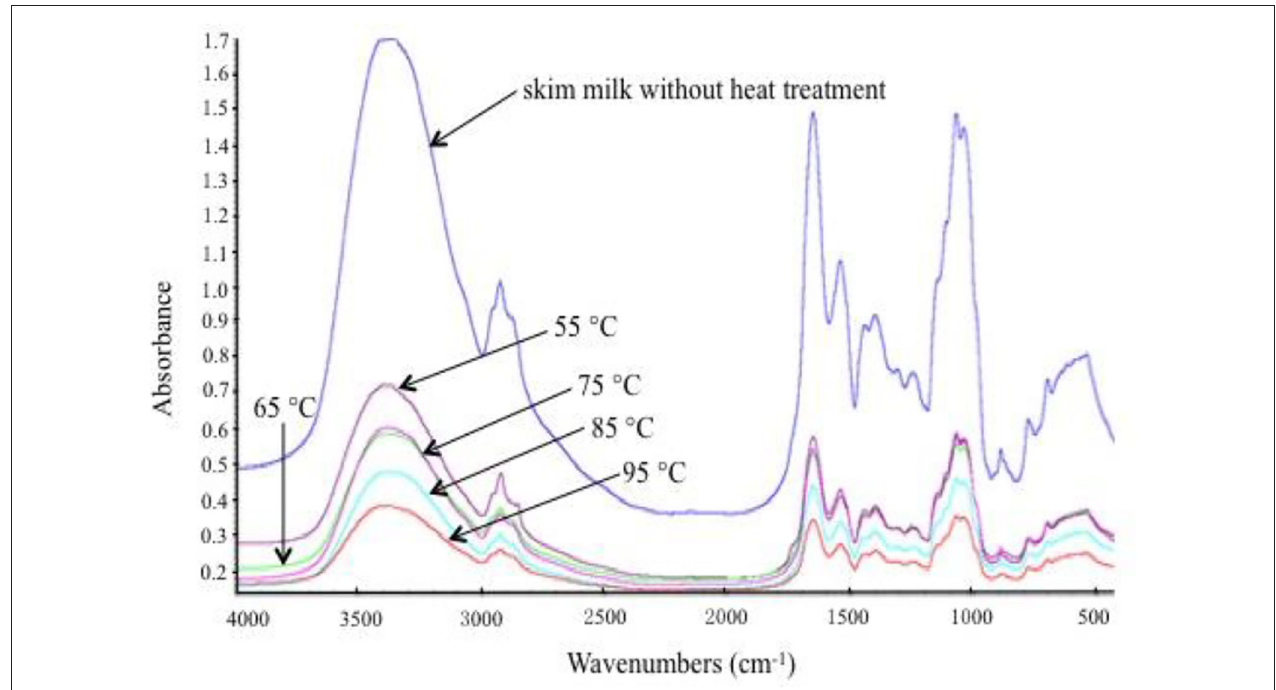
FIGURE 3 | Fourier transform infrared (FTIR) spectra of different heat-treated skim milk.